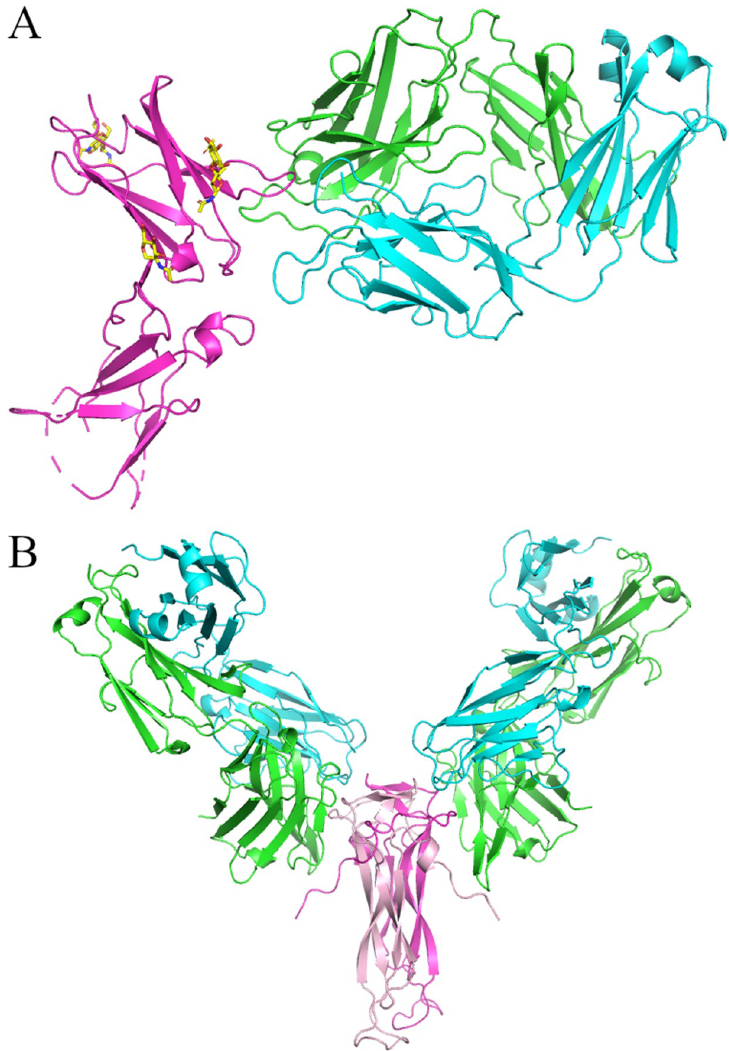
Fig 5. Column fraction crystallization. Column fractions from size exclusion chromatography were used directly in a vapor diffusion crystallization experiment in 4 conditions. (A) shows the chromatogram. (B) shows the images of every crystallization drop at day 9 (C) shows the score assigned to each, where anything crystalline is scored at 90 or higher.